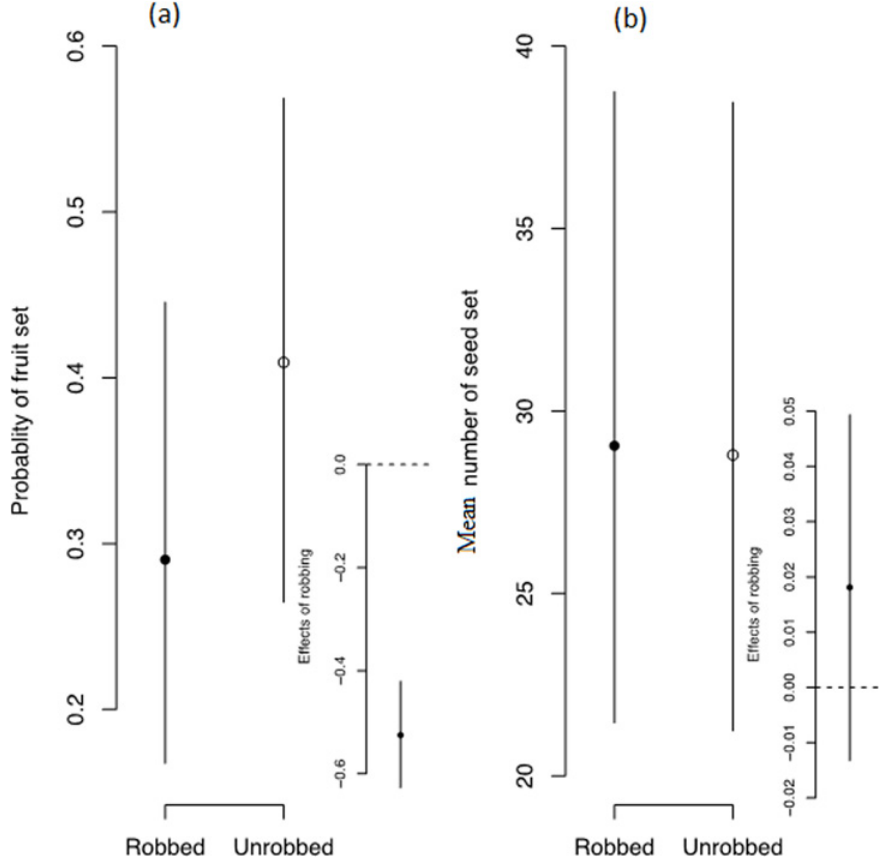
Fig 4. Effect of nectar-robbers on (a) fruit and (b) seed set in Alpinia roxburghii . Open and closed circles represent posterior means and bars represent the 95% confidence interval of the posterior distribution.